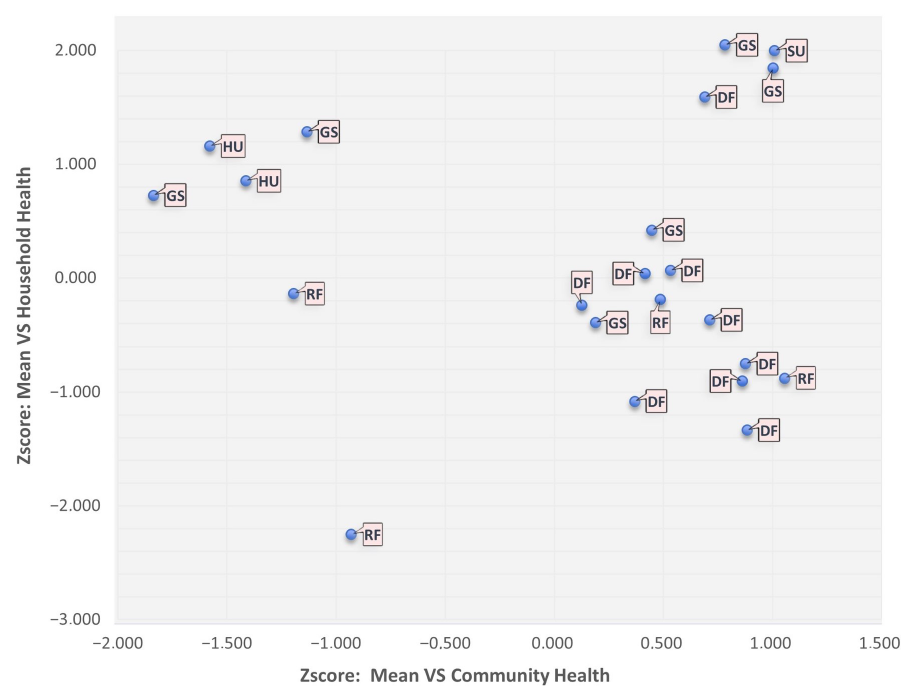
Figure 4. Scatter plot depicting standardized value scores of household health versus standardized value scores of community health at the 22 water sampling stations (HU: Highly urban; SU: Semi urban; GS: Green space; RF: Regenerating Forest; DF: dense